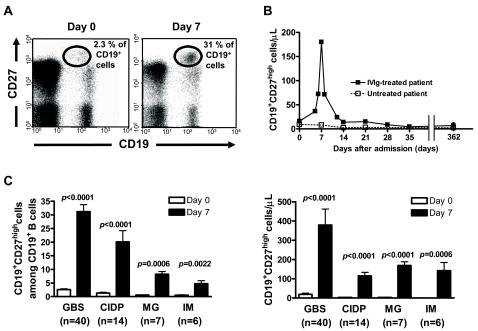
Prospective analysis of plasmacytosis in autoimmune patients.(A) Cytometric analysis of circulating CD19+CD27high plasma cells on day 0 and day 7 of IVIg treatment in a representative GBS patient. Proportions of CD19+CD27high plasma cells among CD19+ cells are indicated. (B) Peripheral CD19+CD27high plasma cell kinetics in representative GBS patients. (C) Proportions among CD19+ cells (left panel) and absolute numbers (right panel) of IVIg-mobilized CD19+CD27high plasma cells. GBS (disability grade 3 or more, n = 40) and CIDP (n = 14) patients received IVIg only, whereas MG (n = 7) and IM (n = 6) patients received IVIg and steroids. Data are mean ± s.e.m. Mean values were compared using Mann-Whitney U test.